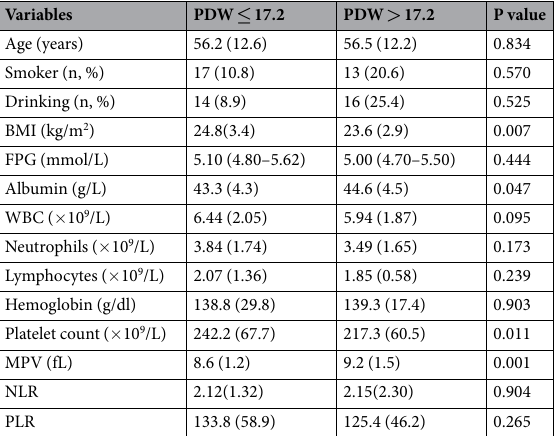
Table 2. Baseline characteristics of melanoma patients according to PDW levels. Data are expressed as means (SD) or median (IQR). FPG, fasting plasma glucose; WBC, white blood cell; BMI, body mass index; MPV, mean platelet volume; PDW, platelet distribution width; NLR, neutrophil-to-lymphocyte ratio; PLR, platelet-to- lymphocyte